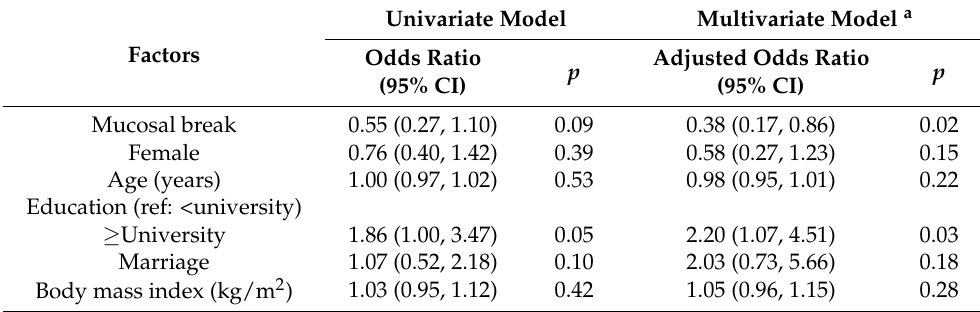
Table 4. Multivariate logistic regression models to examine the factors associated with the improve- ment in the Taiwanese Depression Questionnaire